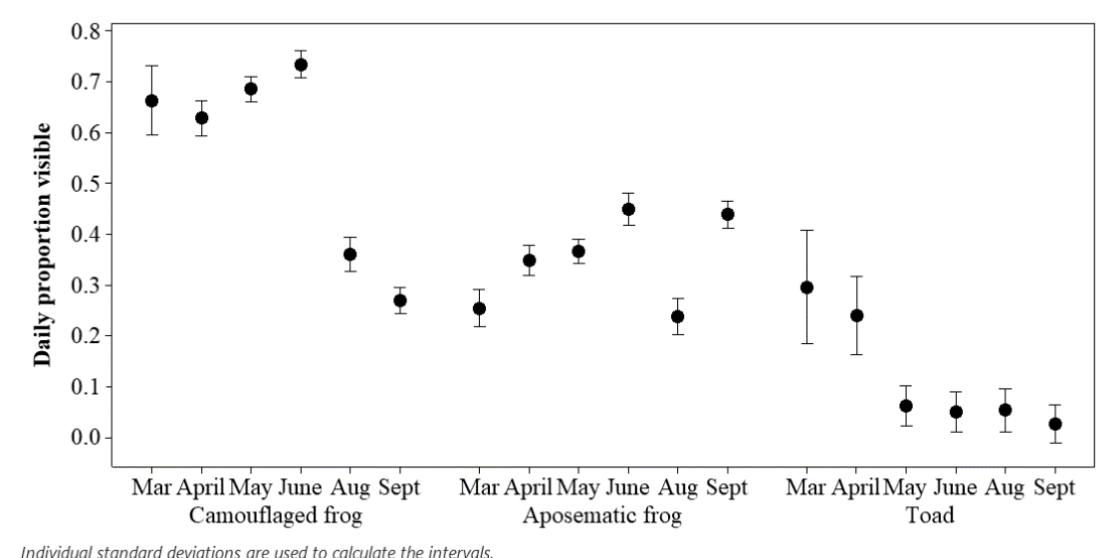
Figure 3. The proportion of camouflaged frogs (common frog and pool frog), aposematic frogs (golden mantella and poison dart frog) and common toad on show for each month of study.